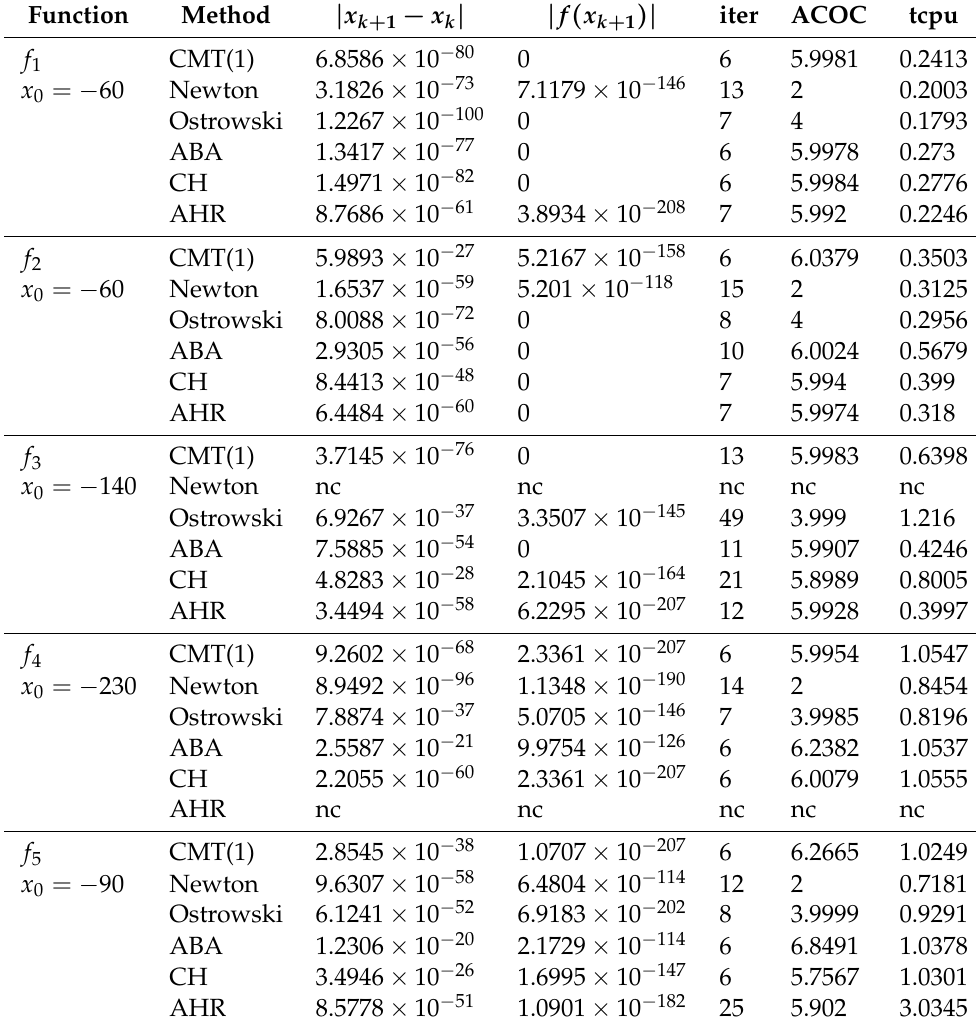
Table 3. Numerical performance of iterative methods in nonlinear equations for x 0 very far from ξ